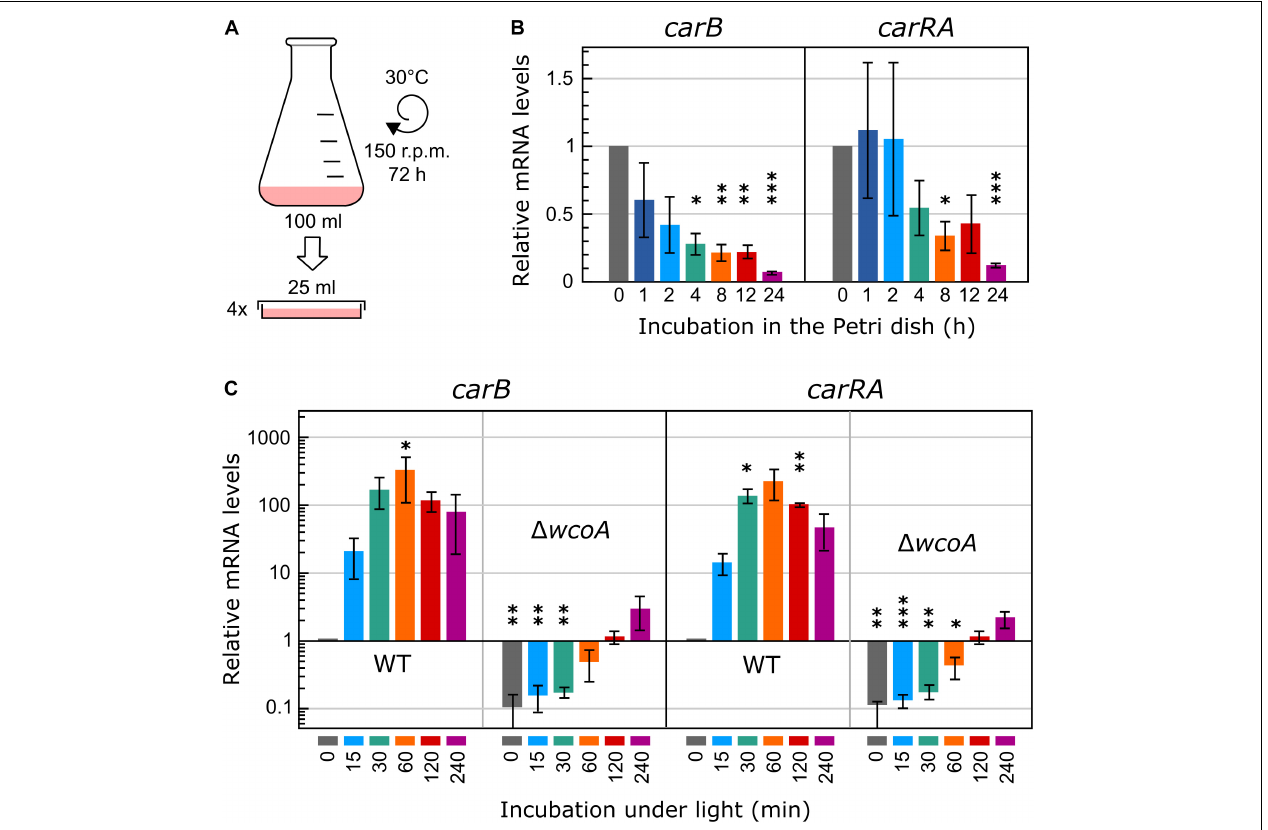
FIGURE 1 | Experimental design and mRNA levels of the carRA and carB genes. (A) Schematic representation of the experimental conditions used for illumination. The cultures were transferred to Petri dishes to improve homogeneous illumination. (B) Effect of the incubation of the mycelia of the wild strain in the Petri dish before illumination on mRNA levels of the carRA and carB genes. (C) Effect of illumination on the mRNA levels of the carRA and carB genes after 4-h incubation in the Petri dish in the dark. In (B) and (C) relative mRNA levels are referred to mRNA content of the wild strain in darkness, and differences with this value found to be significant according to the t tests are indicated ( p -values, ∗ p < 0.033; ∗∗ p < 0.002; ∗∗∗ p <